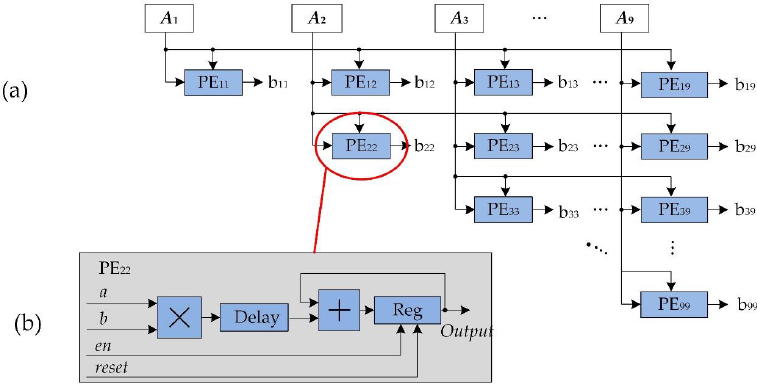
Figure 7. Parallel computation method for A T A. ( a ) is the matrix multiplication unit, ( b ) is multiplicative unit.